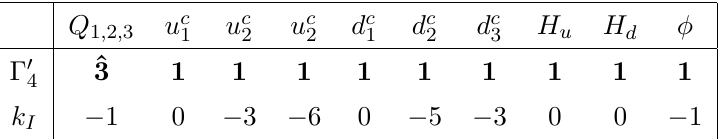
Table 5. The representations and the modular weights of the quarks. This is an explicit model for superpotential with Yukawa coupling of ˆ3 0 in S 0